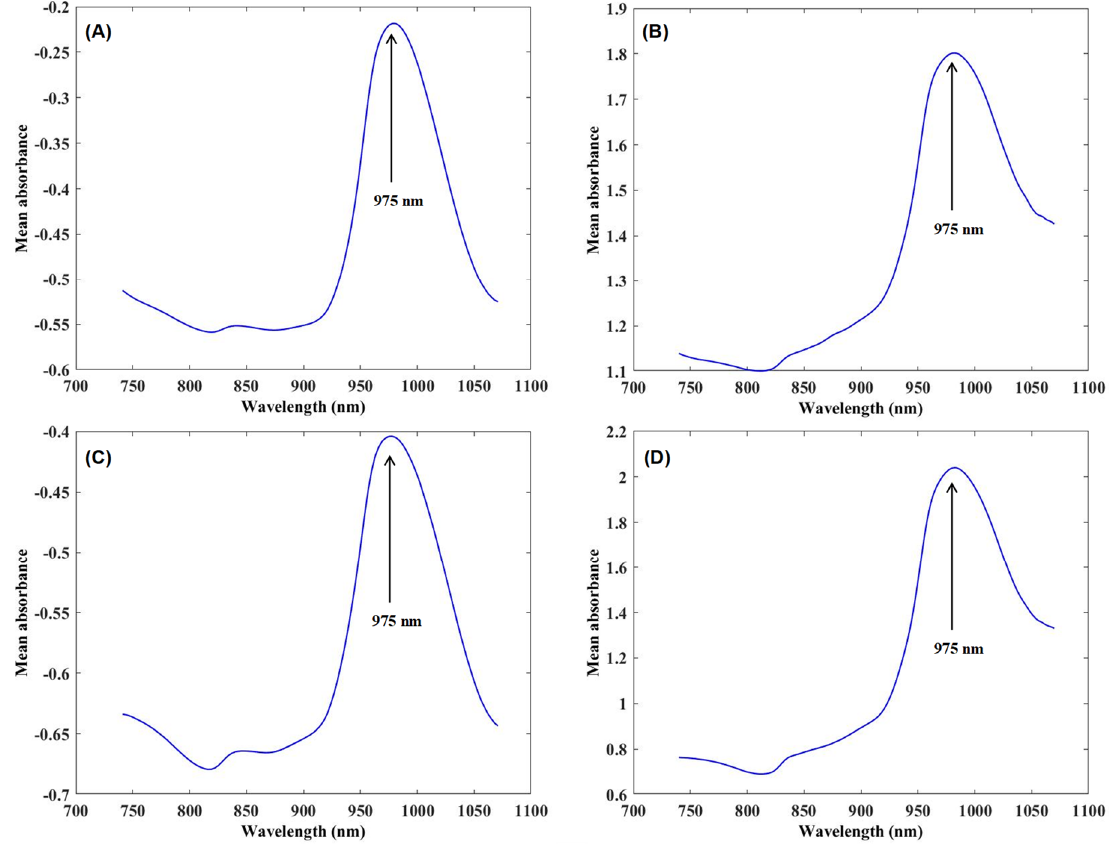
Figure 2. Mean original absorbance spectra for 450 table grapes acquired by ( A ) the F-750, ( B ) the SCiO spectrometers; and for 150 peaches acquired by ( C ) the F-750, and ( D ) the SCiO